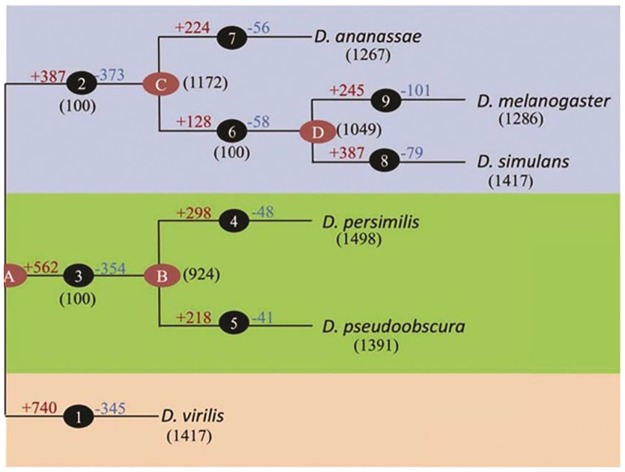
The phylogenetic tree of species.The graph is reproduced with the permission of Joshi et al. (2015).